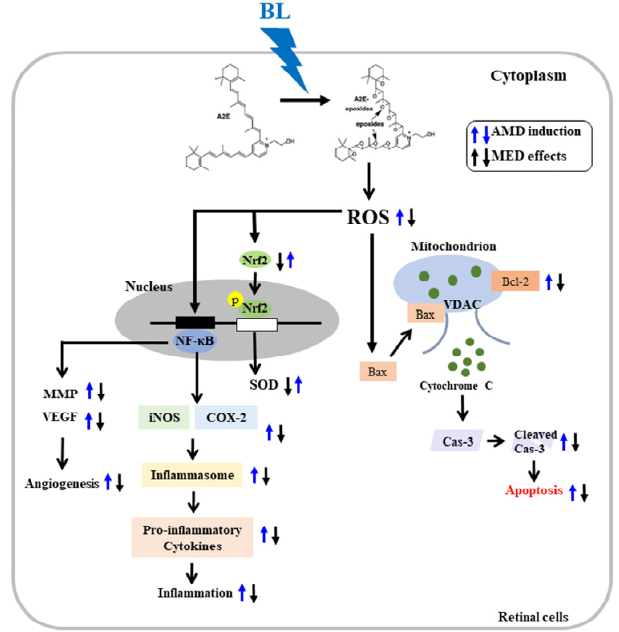
Figure 13. Suggested mechanism of prevention for AMD in the retinal cells. In this scheme, the treatment of MED is thought to inhibit apoptosis, angiogenesis and inflammatory response through enhancing antioxidant activity and suppressing oxidative stress retinal cells with photooxidative damages. Abbreviations: ROS, Reactive oxygen species; Nrf2, Nuclear factor erythroid 2–related factor 2; COX-2, Cyclooxygenase-2; iNOS, Inducible nitric oxide synthase; NLRP3, NLR family pyrin domain containing 3; ASC, Apoptosis-associated speck-like protein; Cas-1, Caspase-1; Bax, Bcl-2-associated X protein; Bcl-2, B-cell lymphoma 2; Cas-3, Caspase-3; BL, Blue light; MED, methanol extracts of Dipterocarpus tuberculatus Roxb.